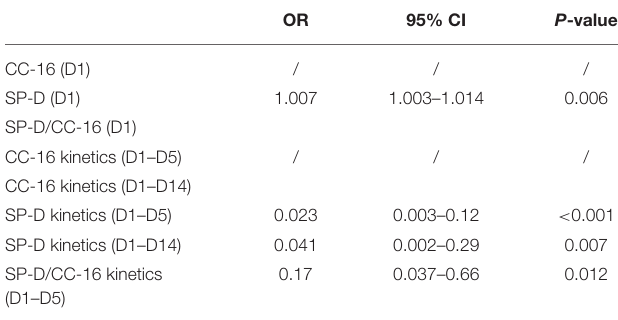
TABLE 5 | Risk for ARDS: Multivariate analysis.